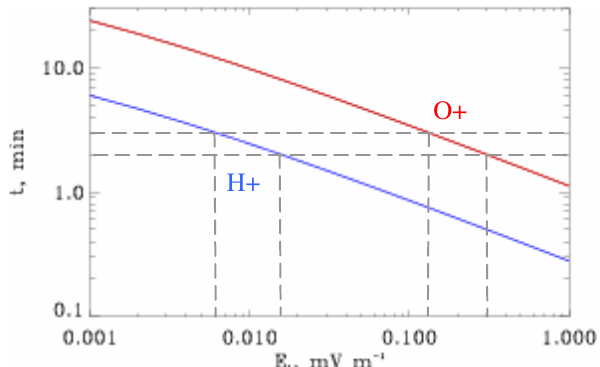
Fig. 14. Variation of O + temperature across the arc measured by ion analyser onboard Demeter (crosses) superposed with the r-g emis- sions observed by ALFA along the satellite